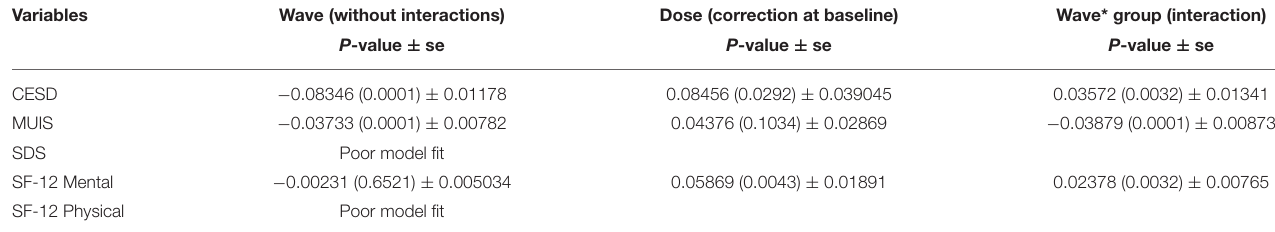
TABLE 5 | Wave-variable